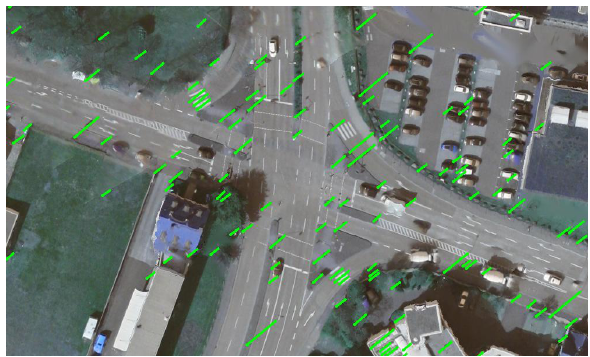
Figure 11. Extracted poles (green lines) and footpoints (green dots), same section as in fig. 2 radar (SAR) ground control points (GCPs) are marked. The radar satellite, the color the quality of the point from green over